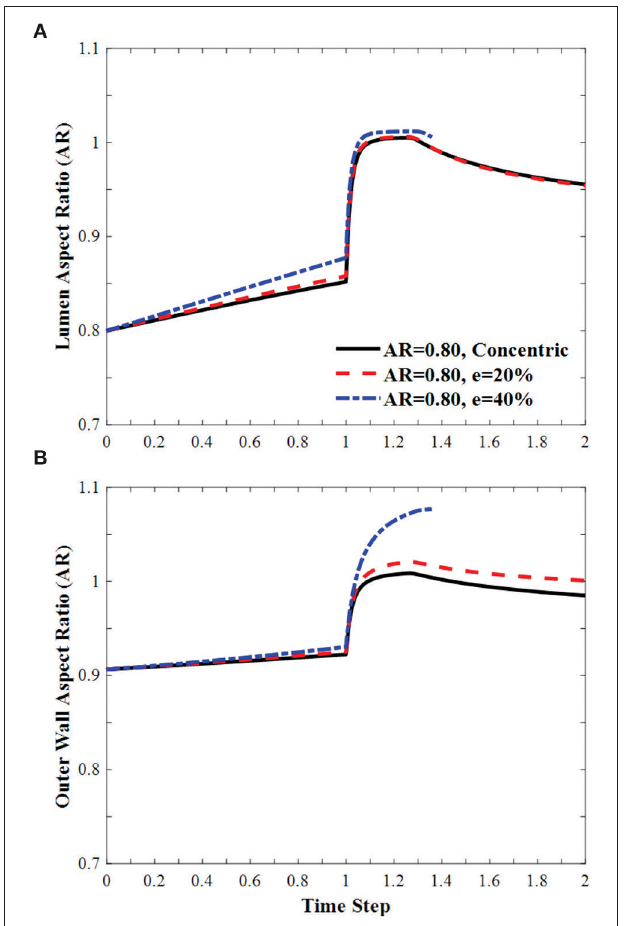
FIGURE 9 | Effect of eccentricity on the AR of the (A) lumen and (B) the outer wall of elliptic arteries with initial lumen AR = 0.8 during the axial stretch and lumen pressure loading process. Initial eccentricity (e) of 0% (concentric), 20 and 40% in the direction opposite to the direction of deflection. The AR is calculated as the ratio of diameter in the buckling direction vs. the diameter in the direction vertical to the buckling direction. Time step is the same as in Figure 3 .